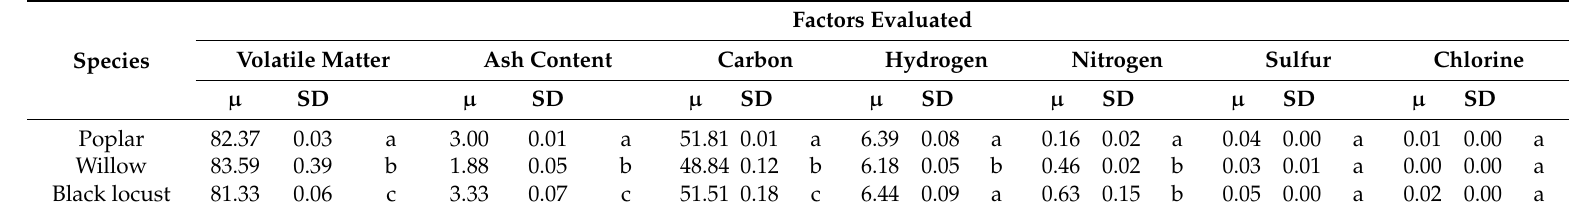
Table 4. Proximate and ultimate analysis (mean values, wt % dry basis).